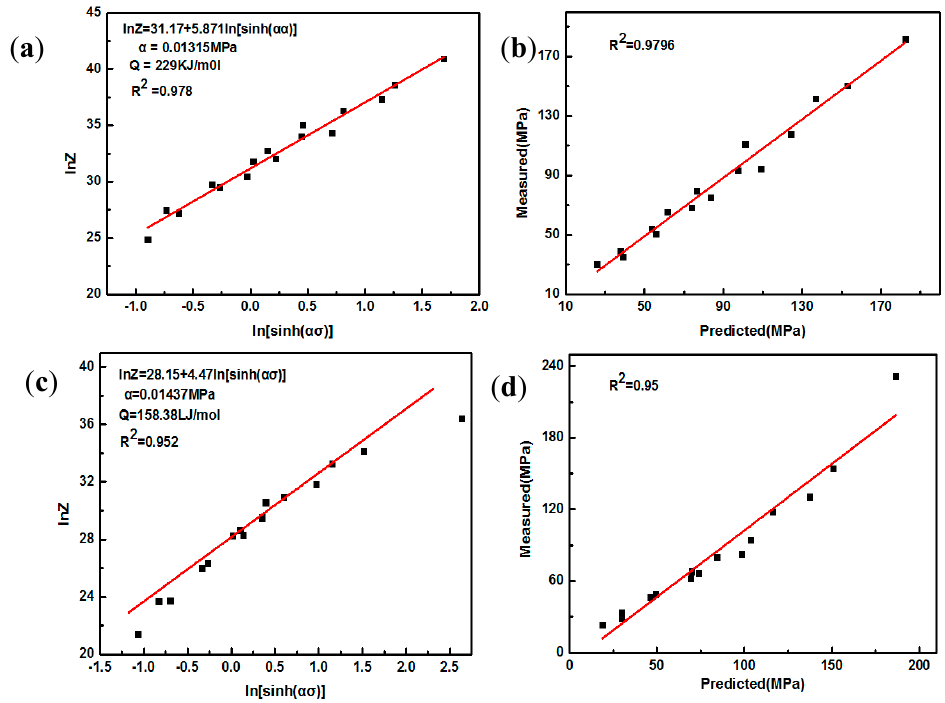
Figure 12. Linear fitting of ( a ) ln Z − ( sinh ( ασ )); ( b ) theoretical-actual stress of AZ91; ( c ) ln Z − l ( sinh ( ασ )); ( d ) theoretical- actual stress of nano-SiCp/AZ91 composite. Table 6. Deformation mechanisms of AZ91 alloy and nano-SiCp/AZ91 composite.